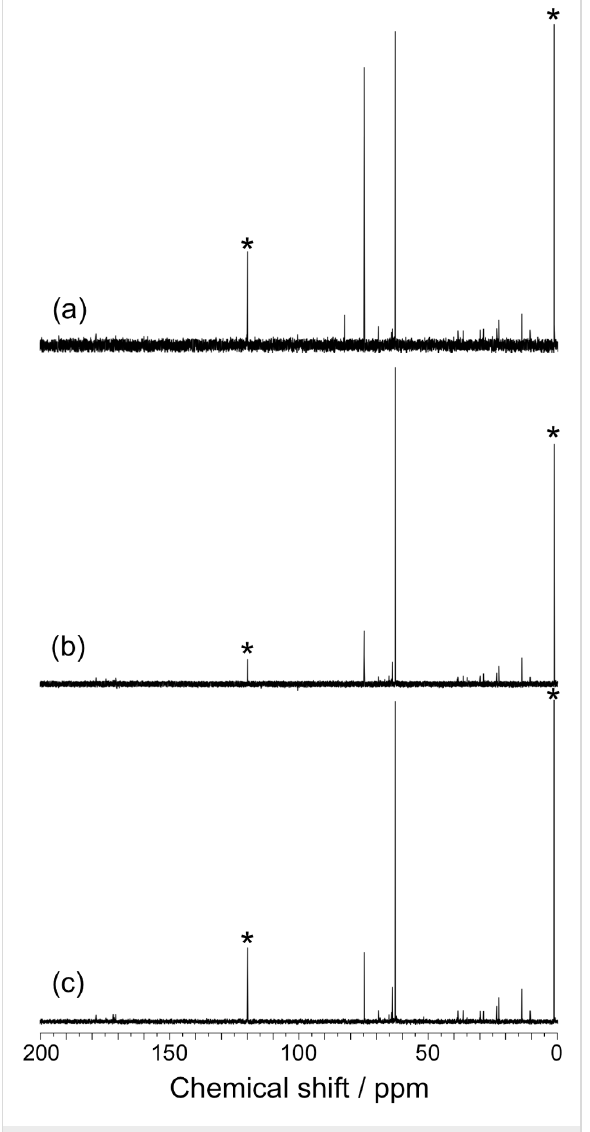
Figure 4: 13 C NMR spectra for the products of the formose reaction carried out in AOT reverse micelles of w = 5 using formaldehyde- 13 C at 35 (a), 45 (b), and 60 °C for 60 min (c). Asterisks represent the signals of acetonitrile, i.e., the internal